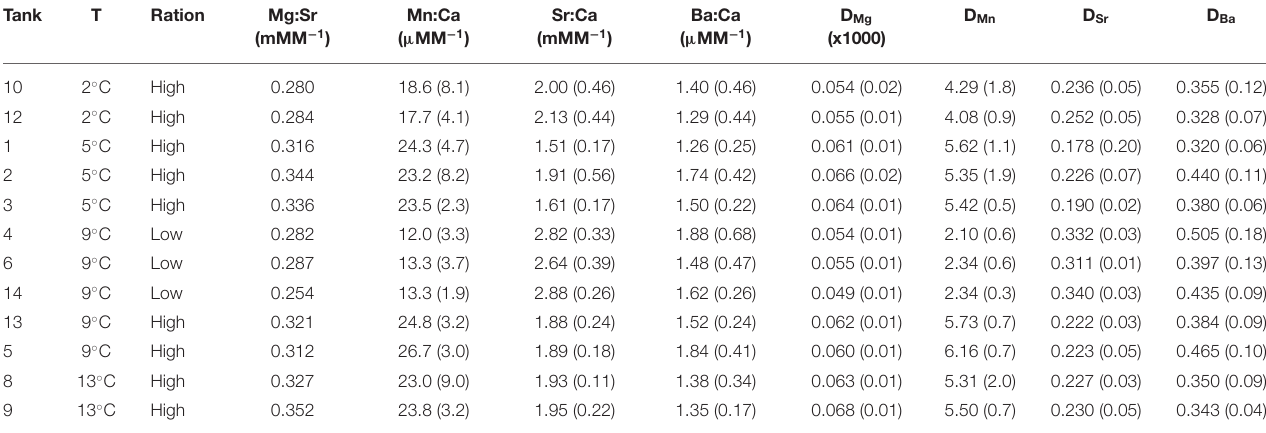
TABLE 5 | Tank mean (standard deviation) for otolith elemental concentrations (Me:Ca) and partition coefficients (D Me ) during the experiment.